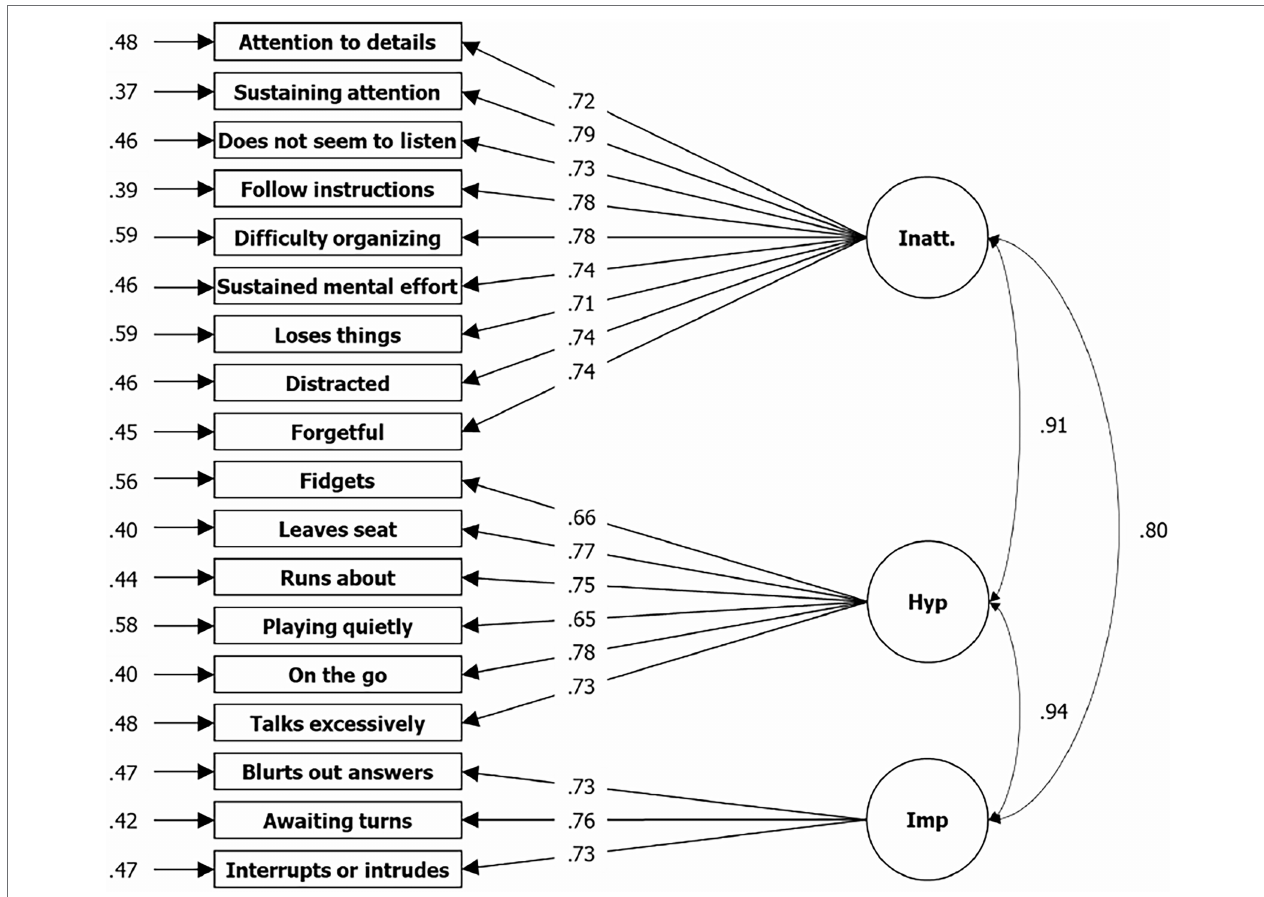
FIGURE 2 | Results from CFA for three factor solution based on symptom items of the ADHD Rating Scale—5. N = 3,736; Loglikelihood user model (H